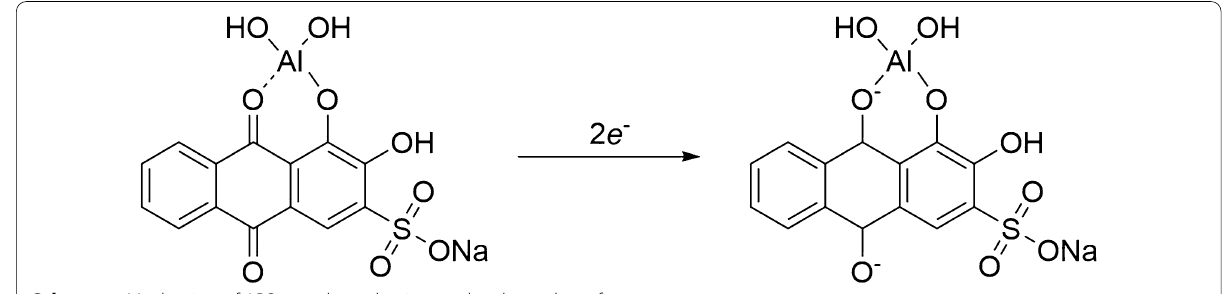
Optical Detection of Al 3 + Alizarin red S (ARS) has been used as a chromogenic agent for developing spectrophotometric methods. Anth- raquinone-metal complexes show strong fluorescence. The fluorescence of metal–ARS complexes is affected